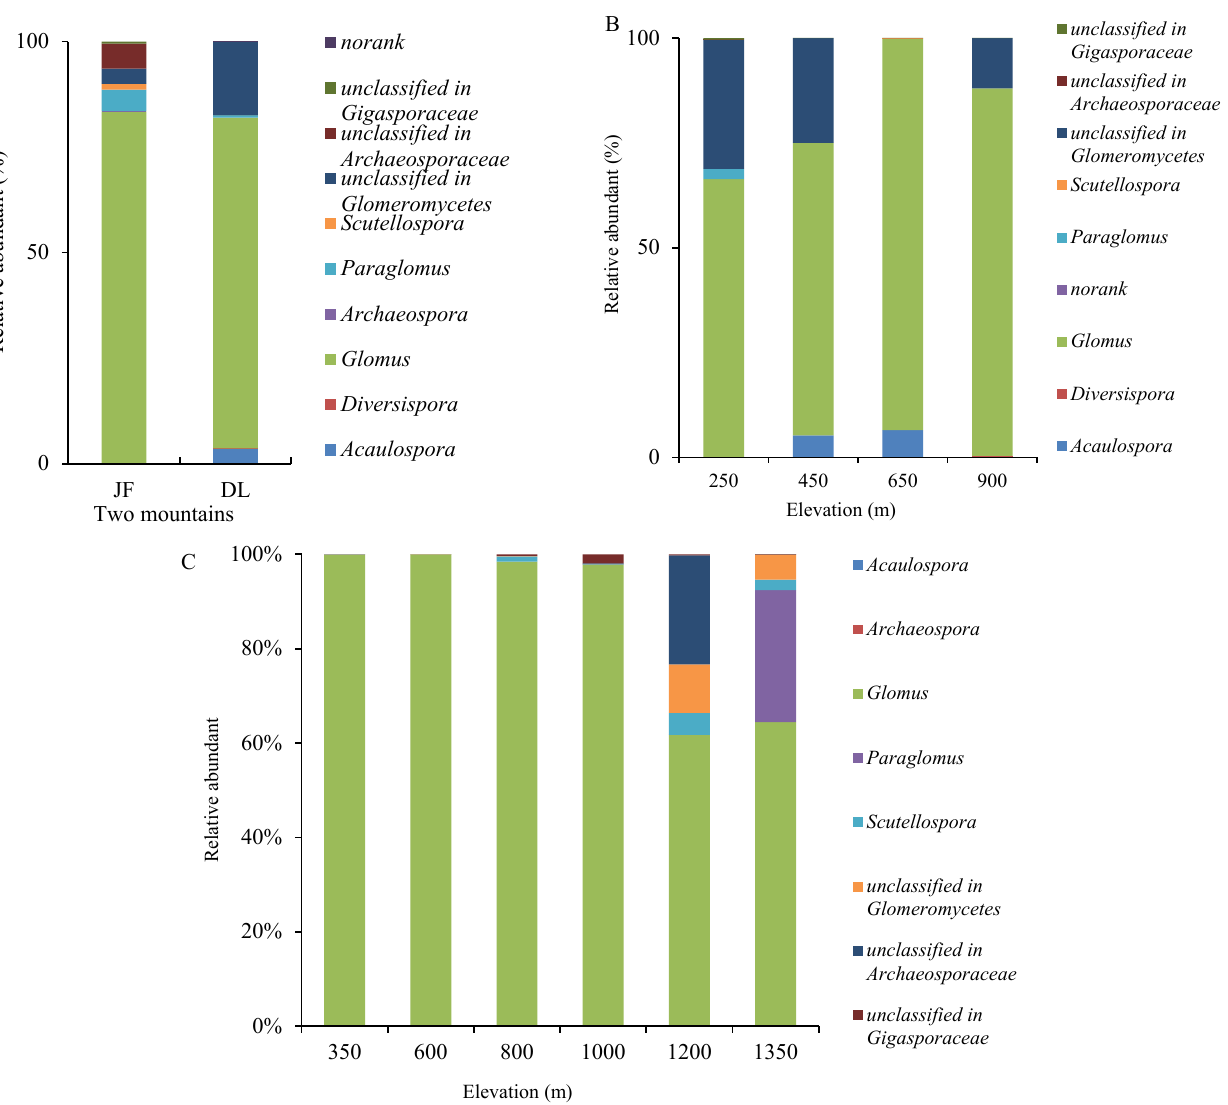
Figure 3. AMF genus relative abundances for the two mountains ( A ) and at different elevations on Mt. Diaoluo ( B ) and Mt. Jianfengling ( C ). Table 1. AMF genus occurrence frequencies at different elevations in tropical forests of China .